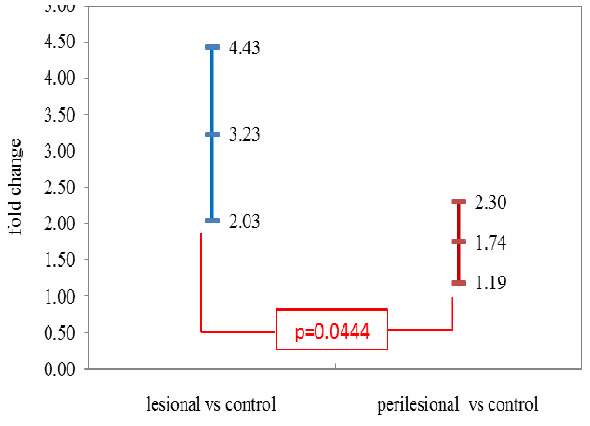
Fig. 1. Mean fold change values for IDO1 in lesional and perilesional areas (95% CI values of FC) Two out of seven patients (28.57%) had mild alopecia areata and all other (71.43%) had severe alopecia areata.